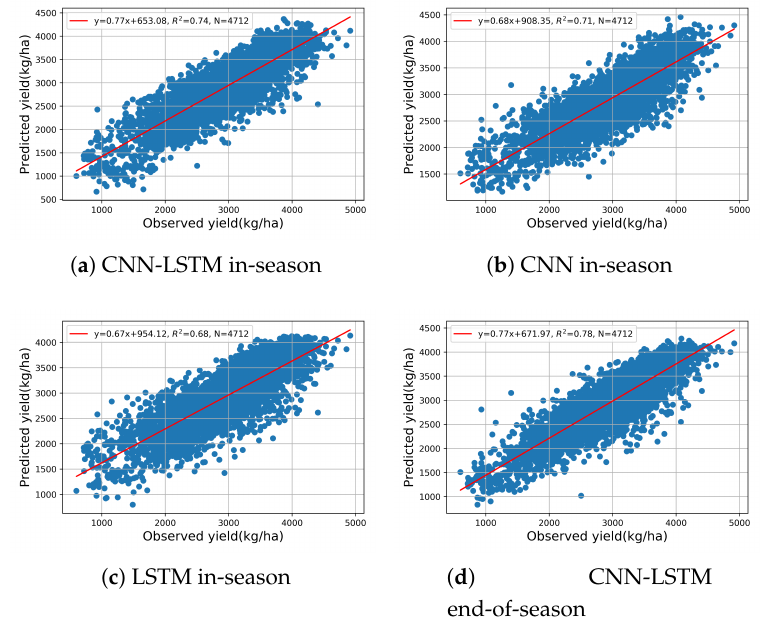
Figure 10. Scatter plots of five-year in-season or end-of-season prediction by different models ( a ) CNN-LSTM in-season. ( b ) CNN in-season. ( c ) LSTM in-season. ( d ) CNN-LSTM